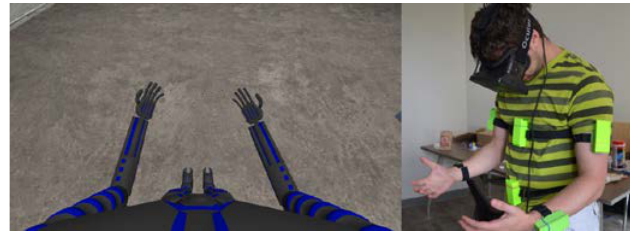
Figure 8.A user playing the game with the Oculus